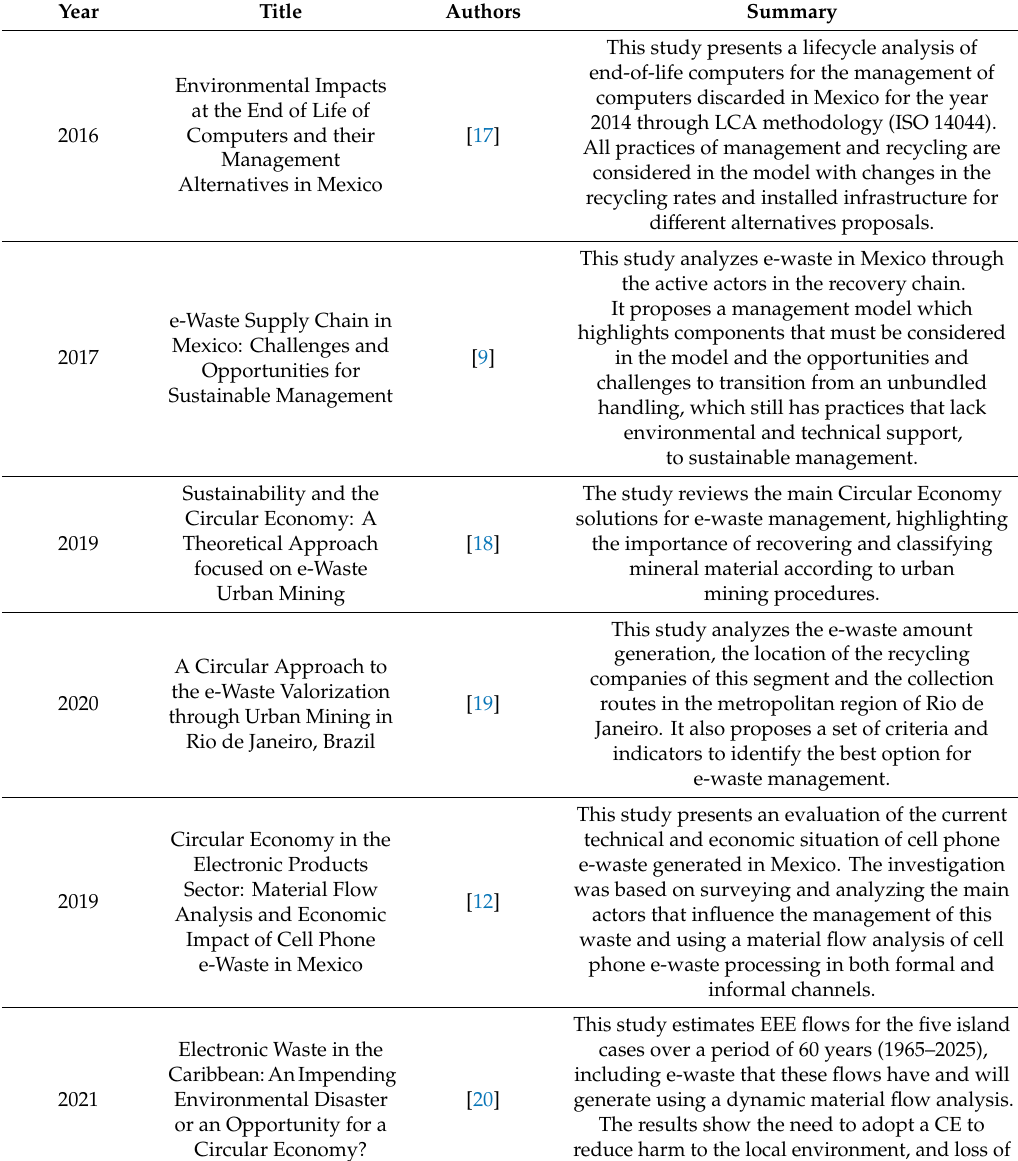
Table 1. SCOPUS search results on “circular economy,” “e-waste,” and “electronic waste” with focus on Mexico and Latin